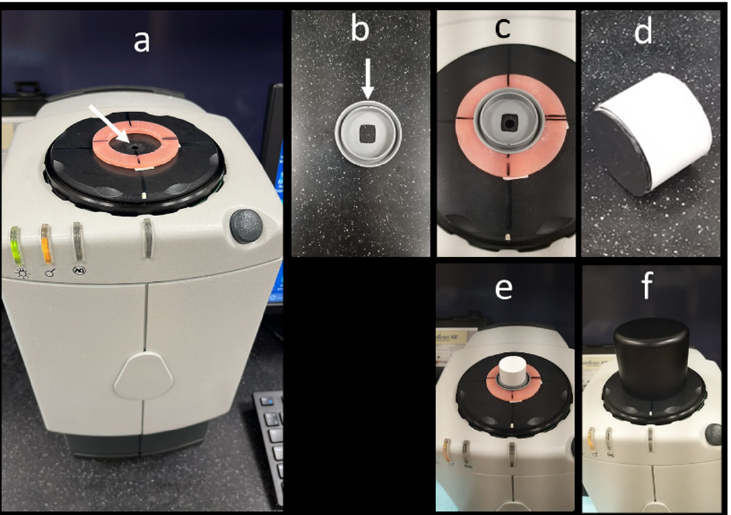
Figure 3. The spectrophotometer device used for color assessment: The white arrow points to the 5-mm diameter measuring window ( a ); A customized jig is fabricated for each material with a rectangular opening with similar dimensions to that of the specimen. A notch at the periphery (arrow) was used to standardize positioning the sample during measurement ( b ); The jig is placed within an acrylic ring fixed around the measuring window. The acrylic ring has four black line markings at 12-, 3-, 6-, and 9 o’clock positions. Three readings for each sample were taken by aligning the notch with the 12-, 3-, and 6 o’clock positions ( c ); A cylinder with a black surface is used as a customized black background ( d ); The cylinder is fitted inside the jig with the black end placed against the sample ( e ); A black cover is placed over the customized background and jig to block ambient light from reaching the measuring window when readings are taken ( f ).